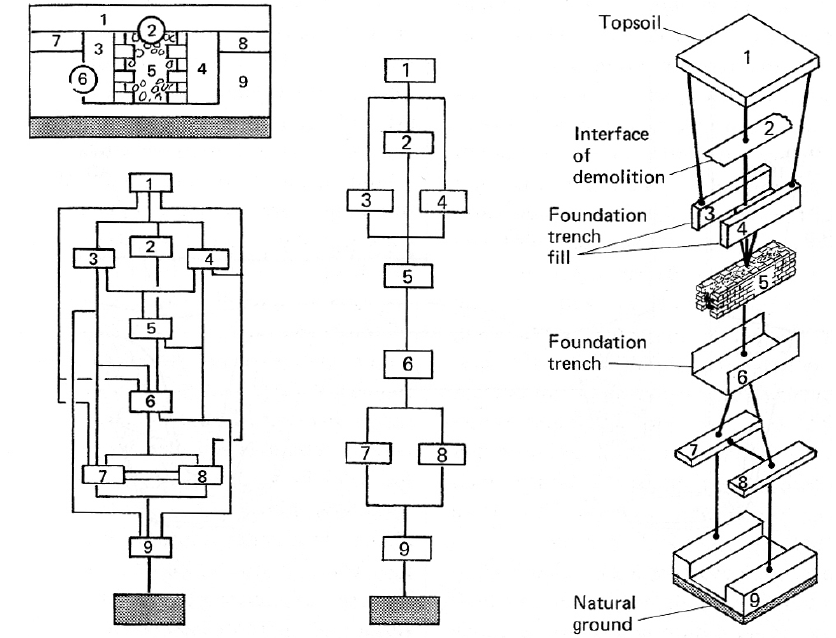
Figure 14. Harris Matrix [48]. Photo: courtesy Edward